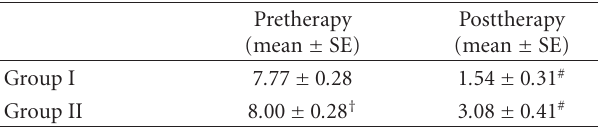
Table 2: The VAS scores pre- and immediately post-therapy in two groups.